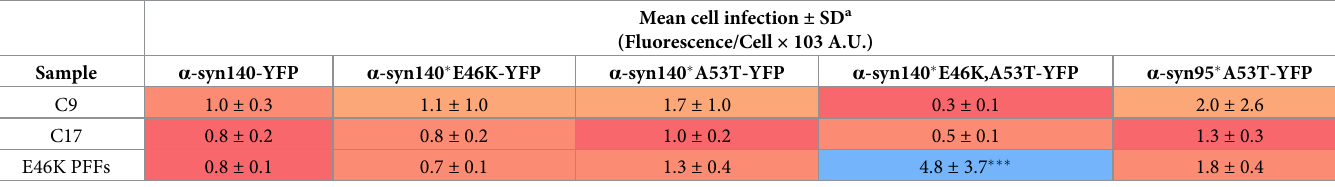
Mean cell infection ± SD a (Fluorescence/Cell × 103 A.U.)